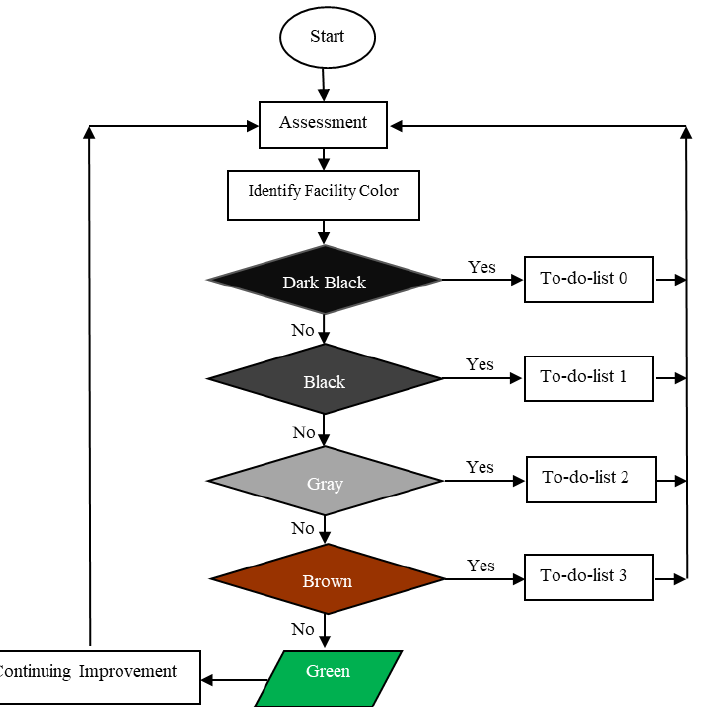
Fig. 3. Procedure of assigning ’To-do-list’ for a certain facility are: Repair blocks prior to cutting, optimizing cutting speed, use thinner cutting discs